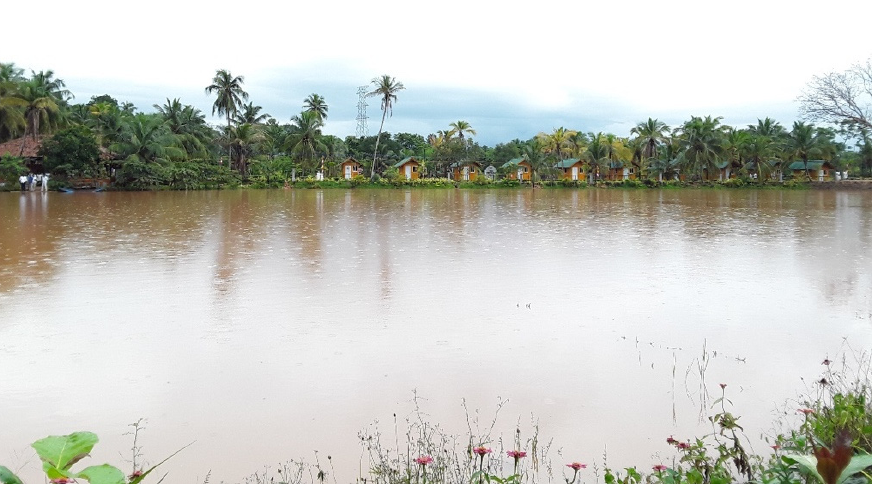
Figure 6. Lake flooded due to rain, Photo by author. 19 October 2019, Umandawa Monastery, Kurunegala.